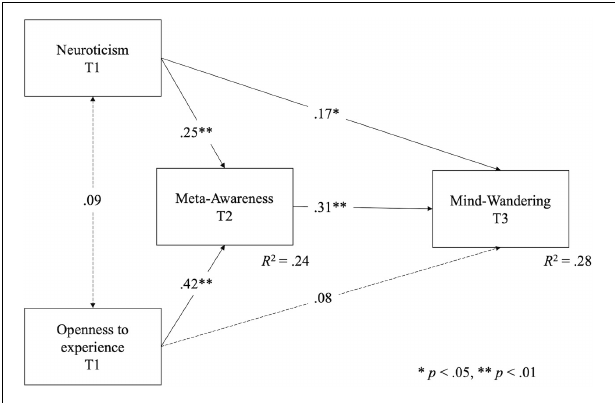
FIGURE 1 | Structural equation modeling for personality, meta-awareness and mind-wandering